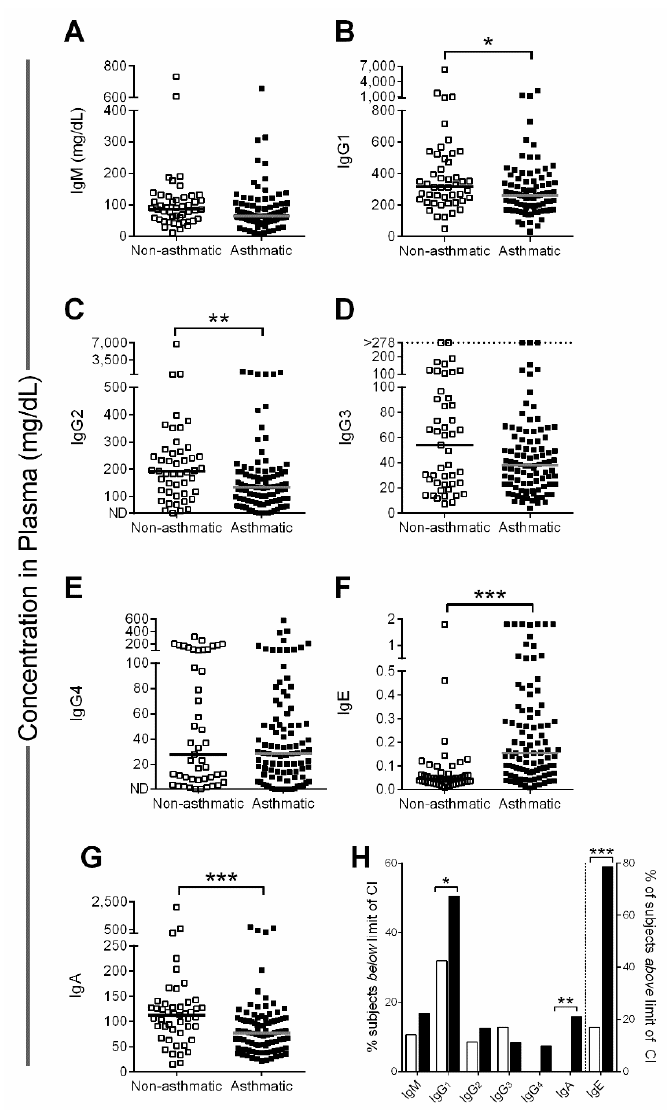
Figure 3. Low immunoglobulin (Ig) levels in severe asthmatics. ( A – G ) Lines show the median in each group. One value for IgE (not shown) in the asthmatic patient group was > 3 mg / dL ( > 12,500 kU / L). ( H ) % subjects outside age-specific immunoglobulin reference range (95% confidence interval [CI]), either below 95% CI (bars to the left of the dotted line) or above 95% CI (bars to the right of the dotted line). Clear and black bars represent control and test patients, respectively. Data were analyzed by the Mann-Whitney U test with significance indicated by * p < 0.05, ** p < 0.01, and *** p <